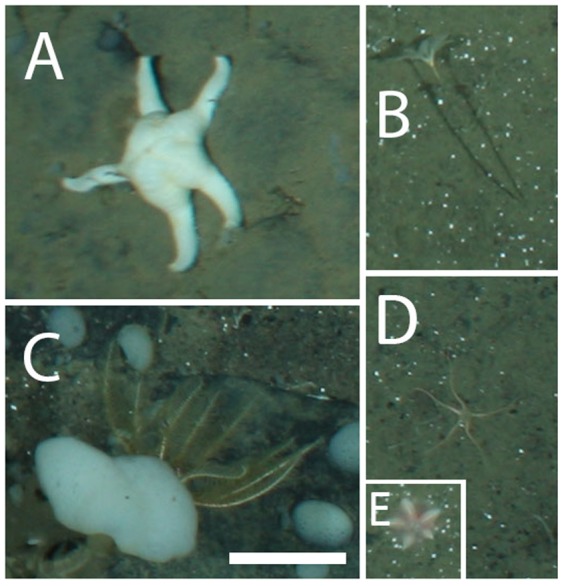
Echinoderms observed at the deep reef.A, Poraniomorpha hispida; B, Bathycrinus carpenterii; C, Poliometra prolixa; D, Ophiostriatus striatus; E, Hymenaster pellucidus. Scale bar  = 5 cm.